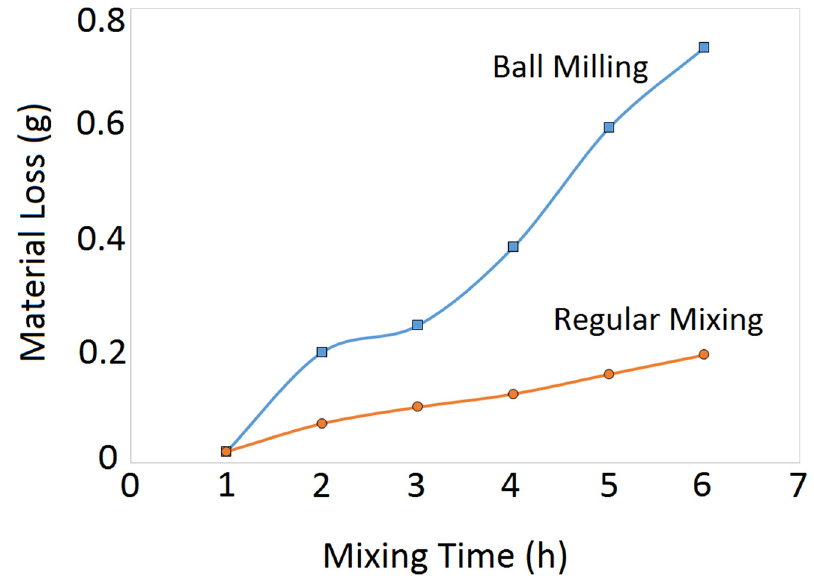
Figure 12. Material loss as a function of the mixing time for the regularly mixed and ball-milled 5 wt.% B 4 C / Ti-6Al-4V composite powders. The starting powder mixture was 100 g, and the ball-to-powder ratio was 5:1.